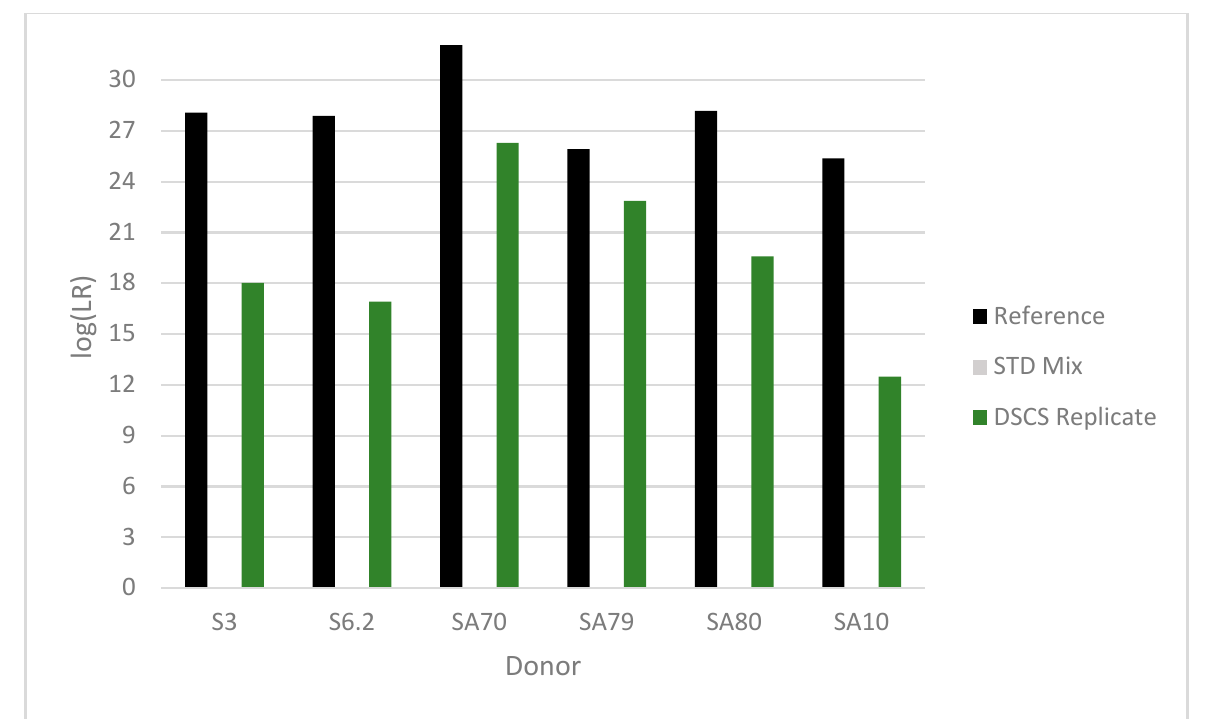
Figure 18. Contributor log (LR) recovery by DSCS (EFM) (“DSCS Replicate”) in an additional 6- person mixture. The “Reference” LR is the reciprocal of the random match probability of the single source DNA profile from the known donor. Standard PG mixture analysis (“STD Mix”) could not be conducted on the mixture due to EFM software limitations. The alphanumeric characters refer to the individual donors present in the mixture.